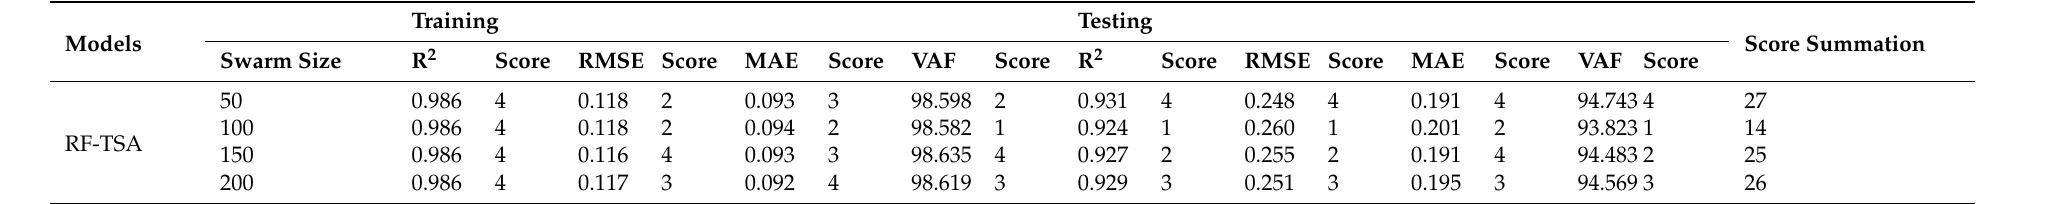
Table 5. Performance of different swarm sizes of the RF-TSA models on predicting the